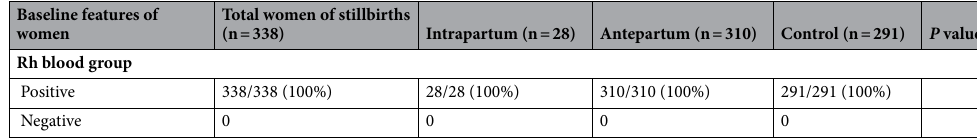
Table 1. Demographic and baseline clinical features of women who had stillbirths. Data are n/N (%). *Comparison of antepartum and control